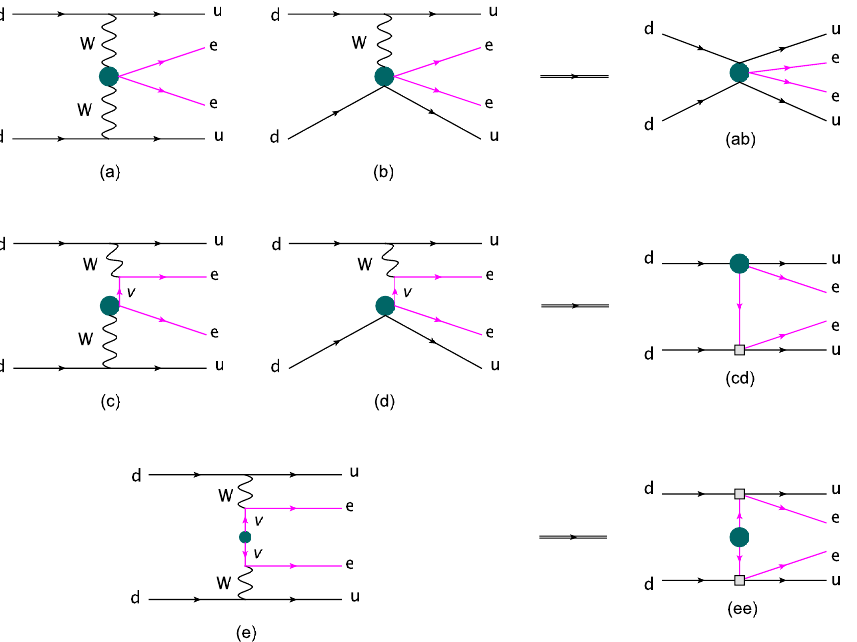
Figure 1 . Quark-level Feynman diagram for 0 (cid:23)(cid:12)(cid:12) from dim-7 (and dim-5 in (e)) operators (heavy dots) in